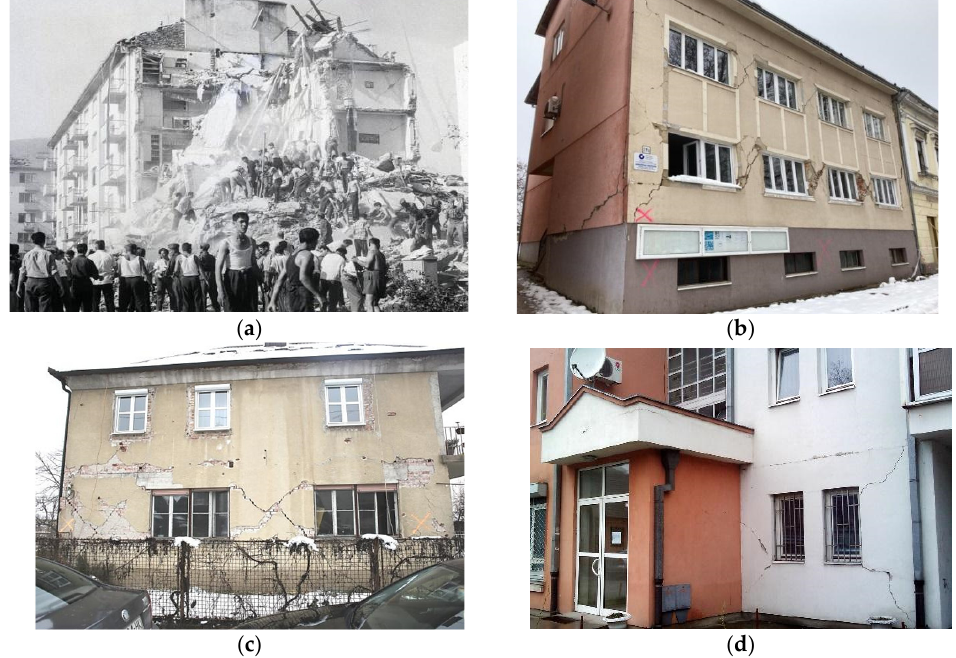
Figure 2. Seismic performance (DSs) of URM residential buildings in past earthquakes in the Balkan region: ( a ) DS5—a collapsed building in Skopje due to the 1963 Skopje earthquake (credit: Z. Miluti- novi ć ); ( b ) DS4—a URM building in Petrinja experienced extensive cracking in wall piers due to the 2020 Petrinja earthquake (credit: SUZI-SAEE); ( c ) DS3—a URM building in Petrinja experienced a major shear-induced cracking in piers at the ground fl oor level due to the 2020 Petrinja earthquake (credit: SUZI-SAEE), and ( d ) DS2—a moderately damaged URM building which experienced mod- erate shear-induced cracking due to the 2010 Kraljevo earthquake (credit: P. Blagojevi ć ).